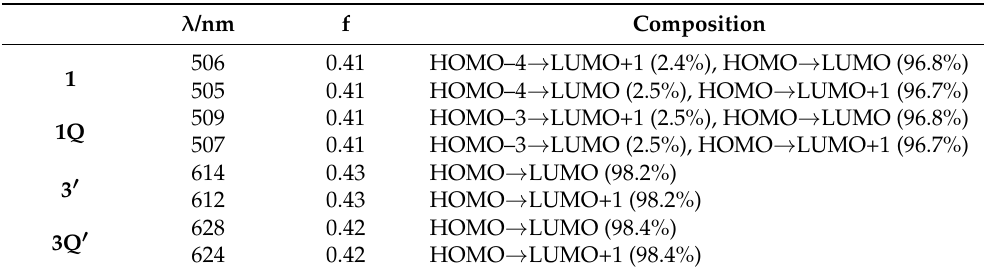
Table 2. Calculated excited wavelengths ( λ ) and oscillator strengths ( f ) for components of selected transition energies. Calculations were performed at the B3LYP/6-31G* level of theory using a polarizable continuum model (PCM), which mimicked the solvation effect of dichloromethane. λ /nm